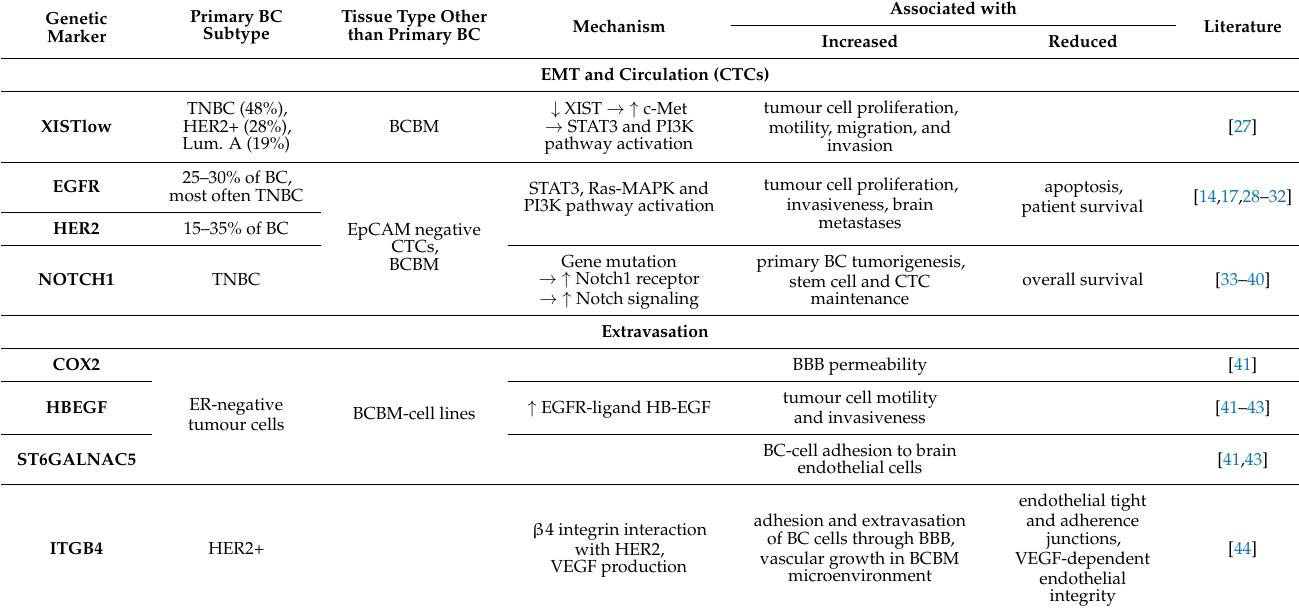
Table 2. Overview of genes and molecular markers associated with increased BCBM formation, including the associated primary BC subtype and/or tissue type in which they are most commonly detectable and the mechanism by which BM development is thought to be promoted. Shaded rows roughly divide the markers into groups based on the metastases phase in which the variable exerts its